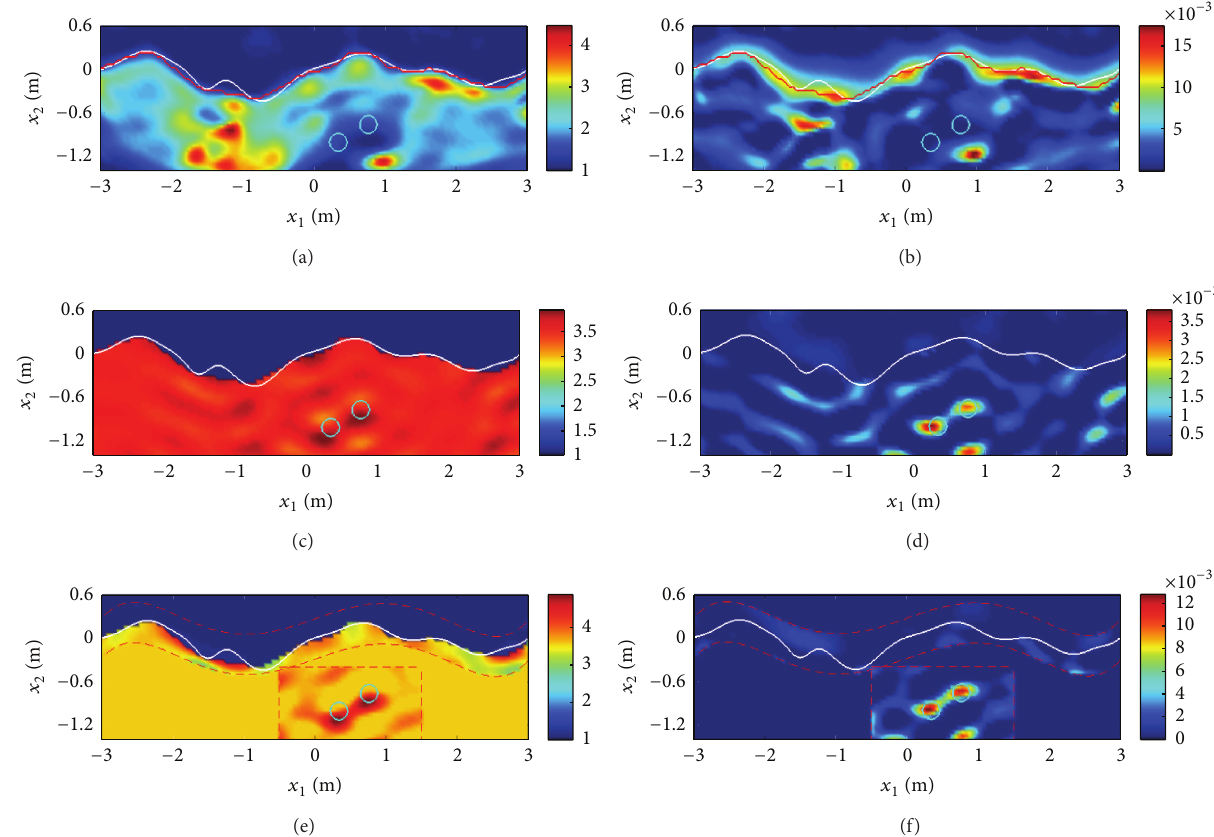
Figure 5: (a) Reconstructed permittivity and (b) conductivity profiles and the determination of the rough surface after the first stage. Final results of permittivity and conductivity profiles ((c)-(d)) for the entire domain and ((e)-(f)) for the narrowed domain.